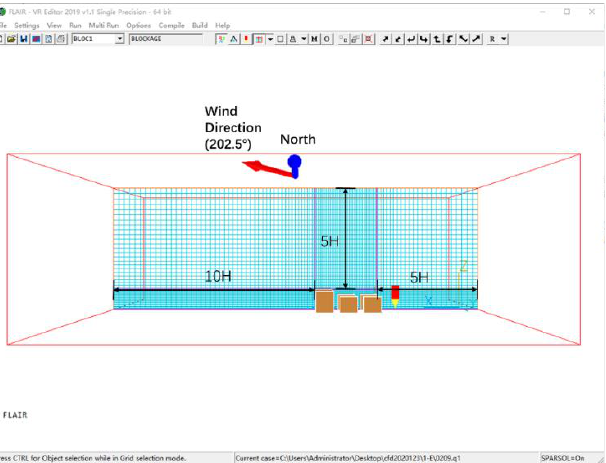
Figure A4. The Z plane grid distribution for seven layout modes (1-E used as the example).